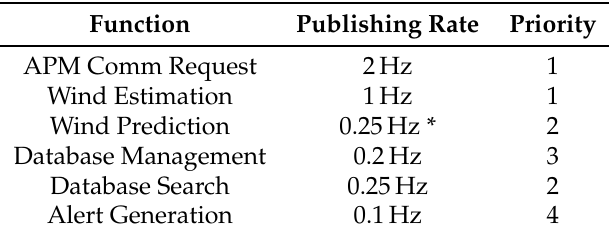
Table 2. Communication Scheme of Handler. The publishing rate which was determined based on the results found in [9] and the priority based on the system